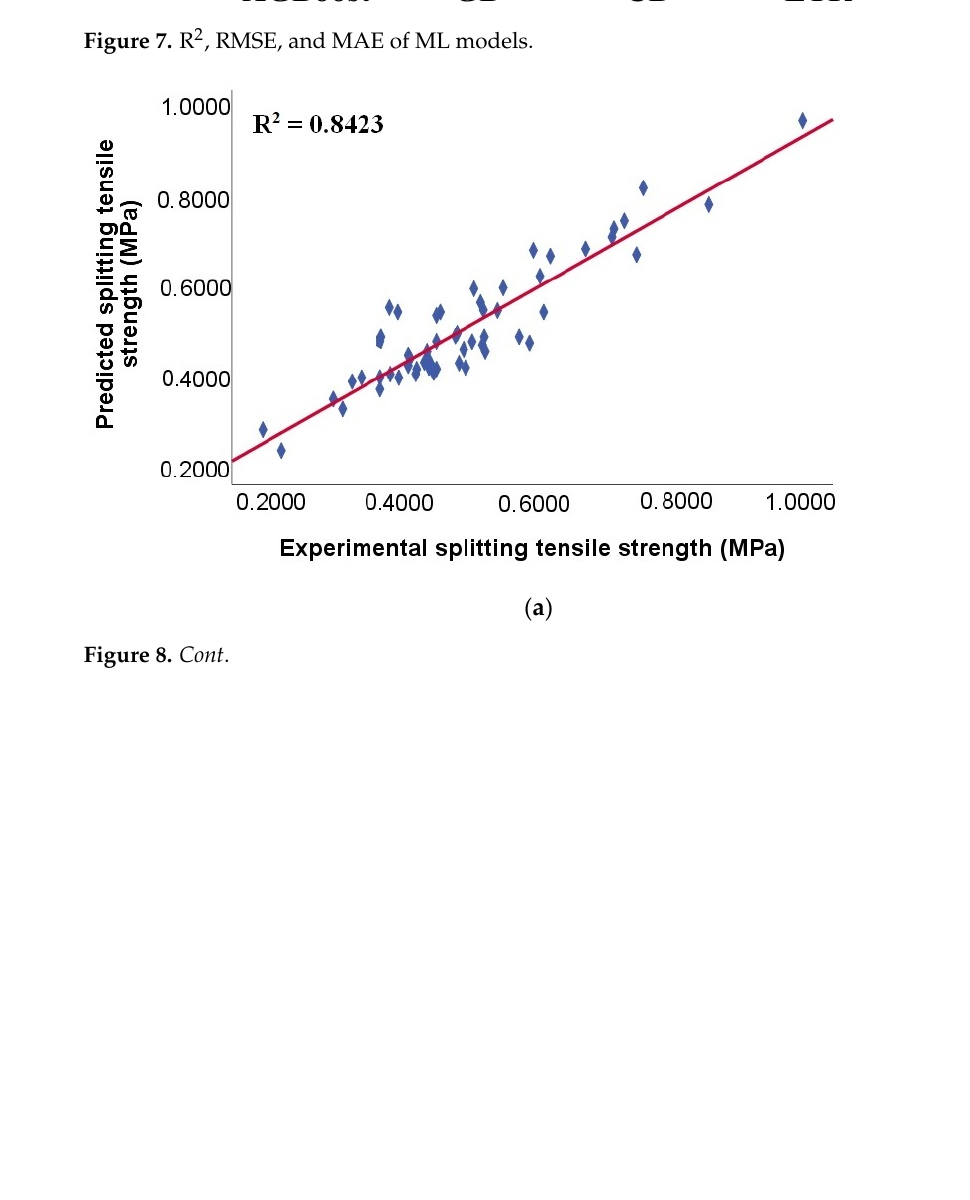
Figure 7. R 2 , RMSE, and MAE of ML models.